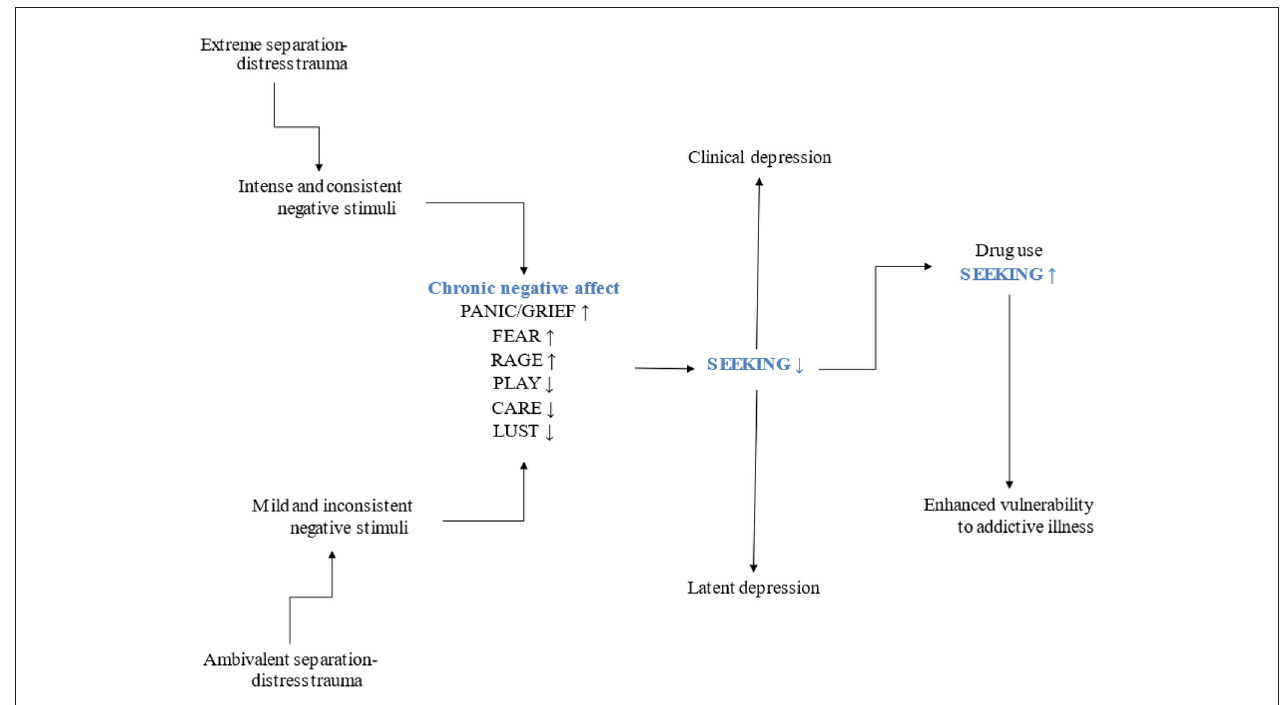
FIGURE 2 | The two types of separation-distress trauma and their impact on affect.